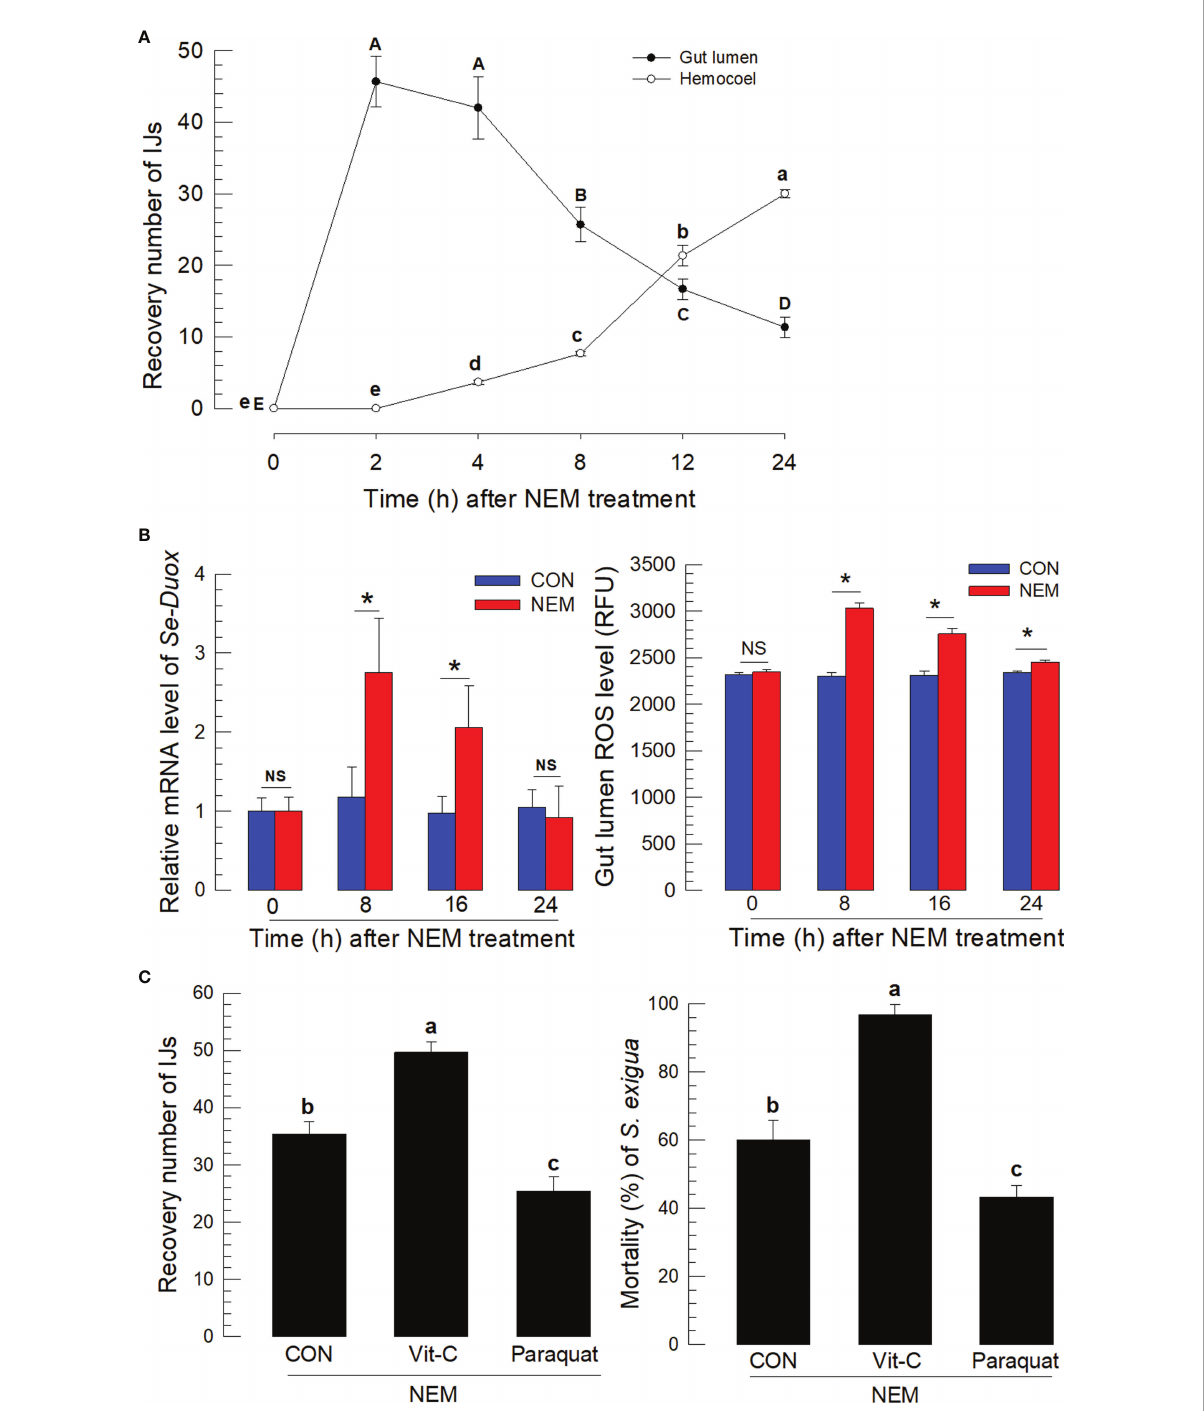
FIGURE 1 Entomopathogenic nematode ( ‘ NEM ’ ) infection to S. exigua gut leads to ROS burst. Each L5 larva of S. exigua was fed with 80 IJs of S. feltiae . (A) Temporal IJ infection from gut lumen to hemocoel after oral feeding treatment. (B) Induction of Se-Duox expression and ROS level. (C) Modulation of ROS levels against the nematode infection and subsequent virulence to S. exigua . L5 larvae were infected with IJs at 24 h after vitamin C ( ‘ Vit-C ’ , 100 mg/larva) and paraquat (25 µg/larva) treatment. Larval mortality was recorded 72 h after the nematode treatment. Each treatment was replicated three times. Different letters and asterisks above standard error bars indicate signi fi cant differences among means at Type I error = 0.05 (LSD test). NS, no signi fi